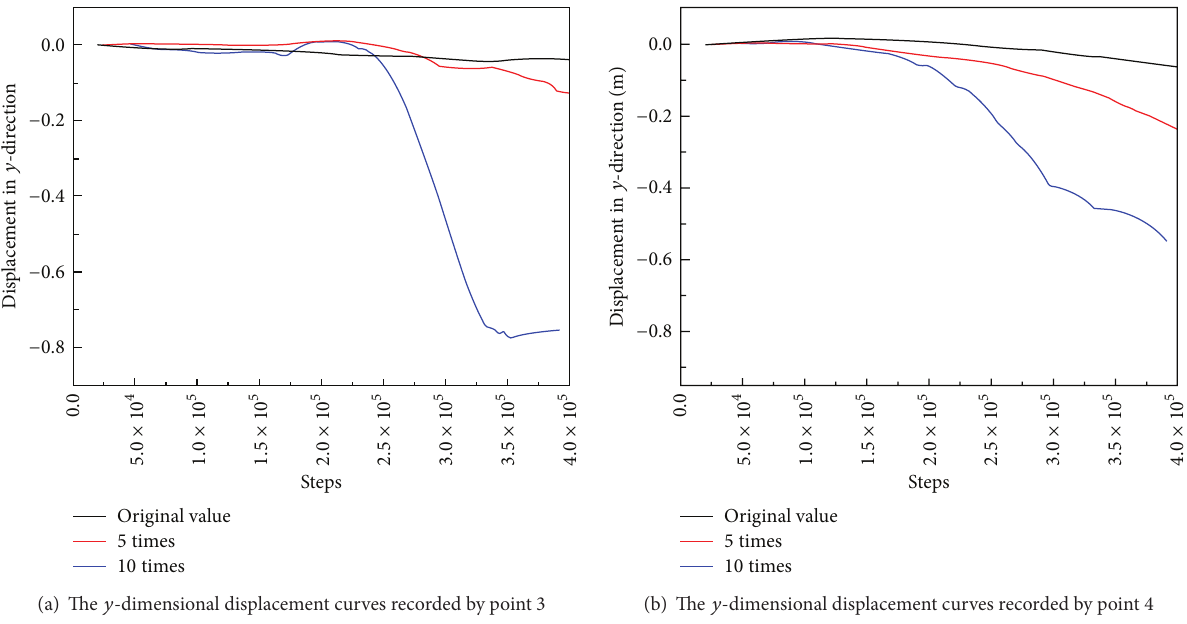
Figure 10: The changing curves of 𝑦 -dimensional displacements of monitoring points 3 and